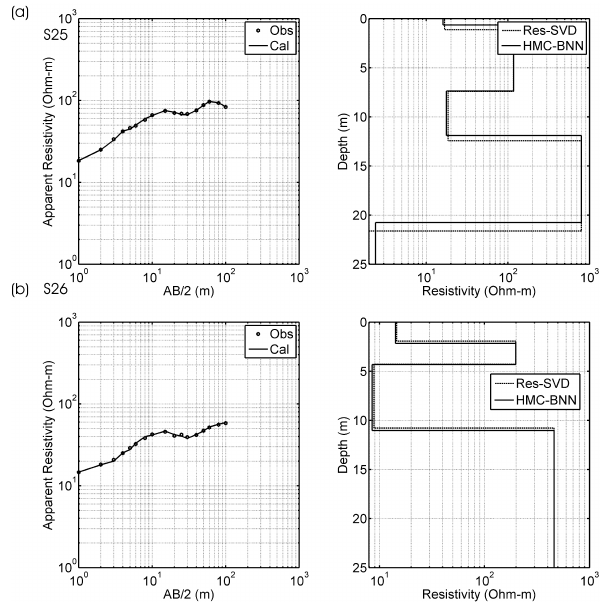
Fig. 7. The comparison of Hybrid Monte Carlo (HMC)-based Bayesian neural network (BNN) inversion results with singular value decomposition (SVD)-based conventional resistivity inver- sion results for soundings (a) s25 and (b)